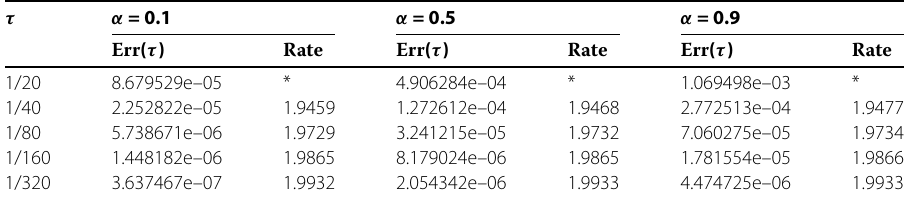
Table 2 Numerical errors and convergent orders with λ = 2, T = 1, when q = 2